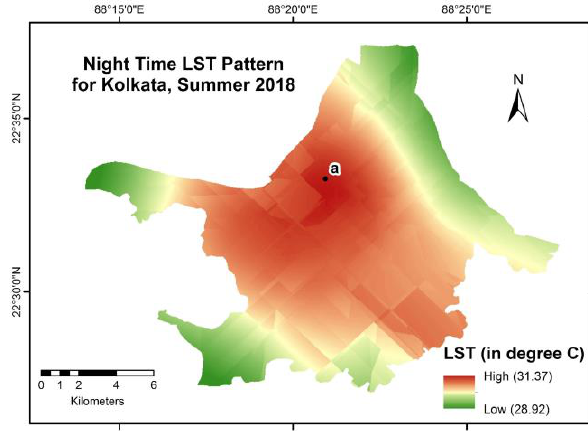
Figure 10. Night time LST profile of Kolkata for summer, 2018